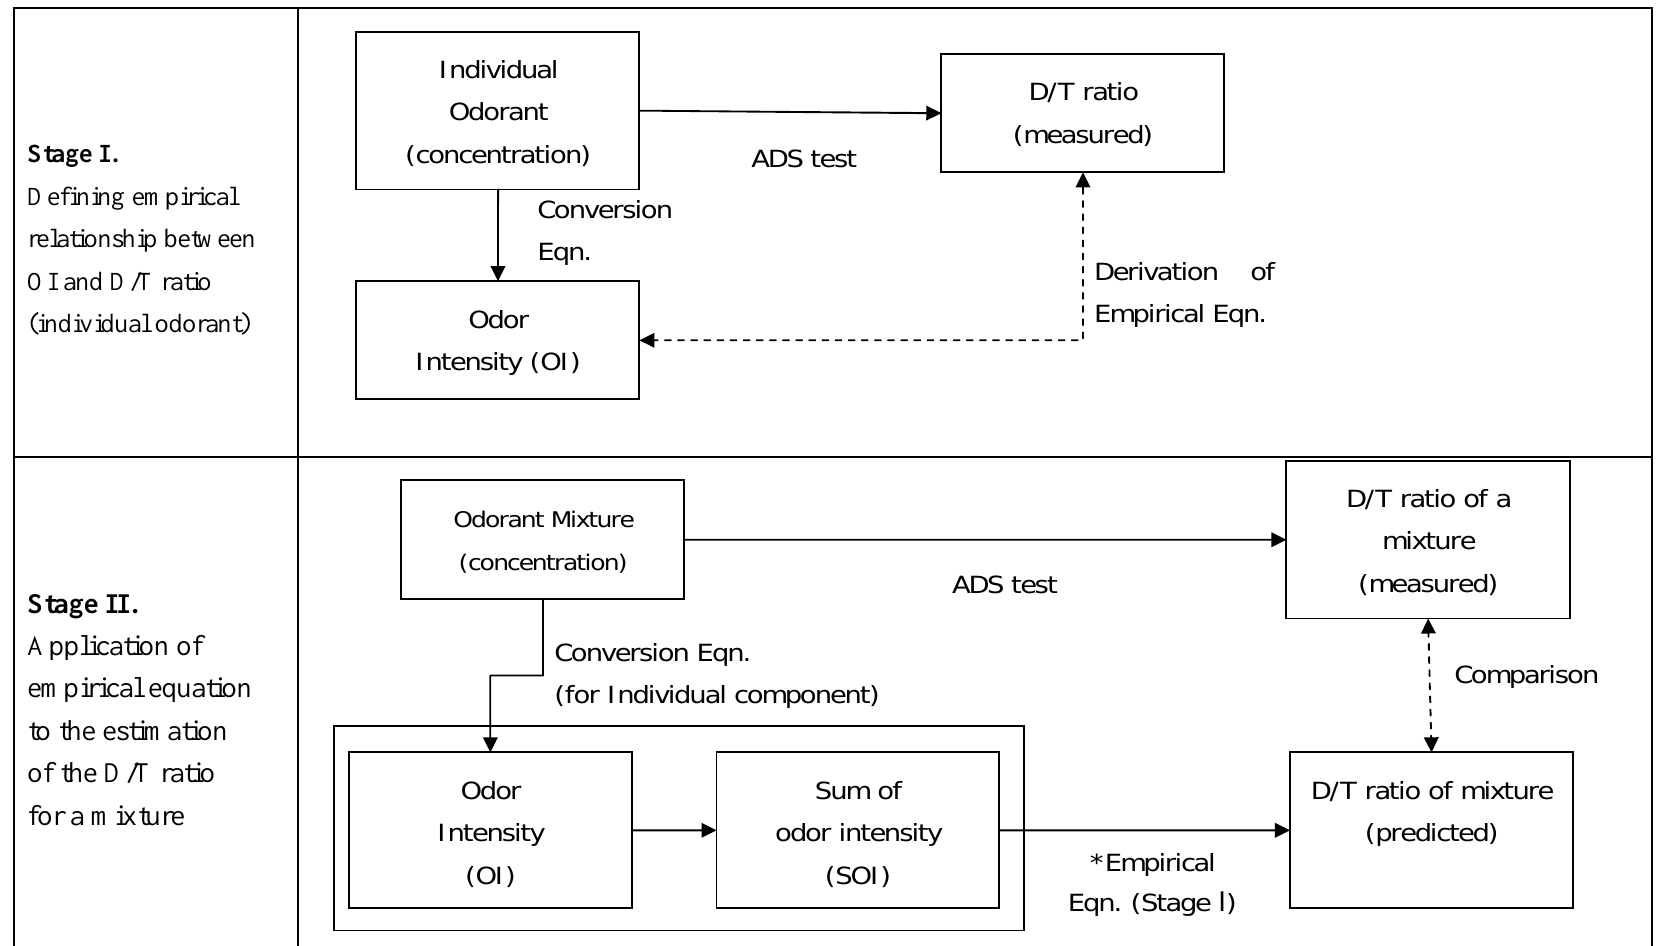
Figure 1. Schematic of the two-stage approaches for (1) the estimation of empirical relationships between D/T ratio and odor intensity of individual odorants and (2) the application of such relationships to mixed odorants.